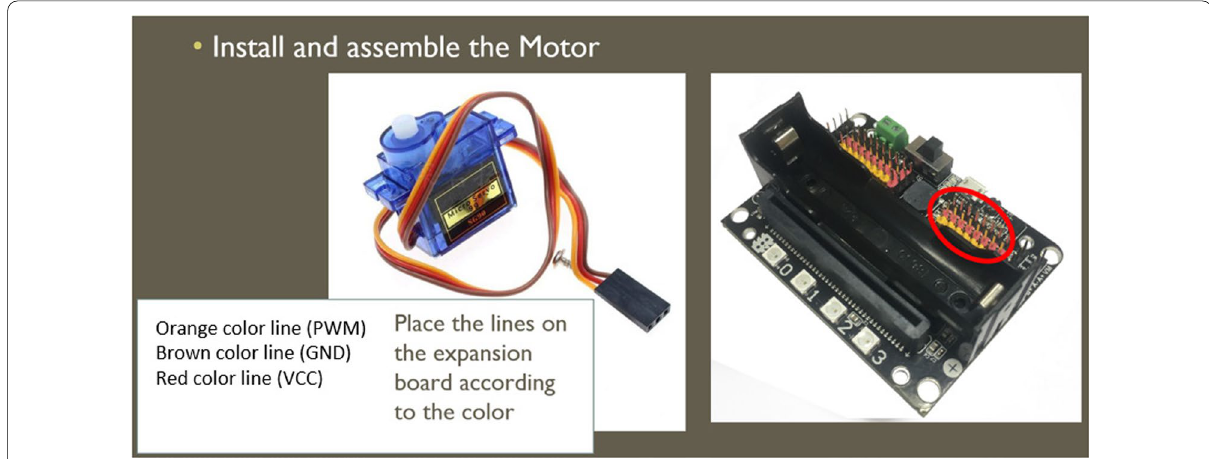
Fig. 4 An illustration of STEAM teaching